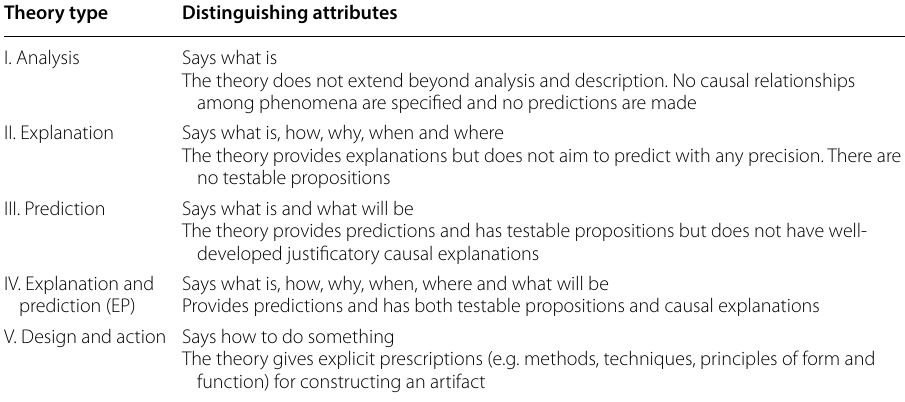
Table 1 A taxonomy of theory types in information systems research [16, p. 620]